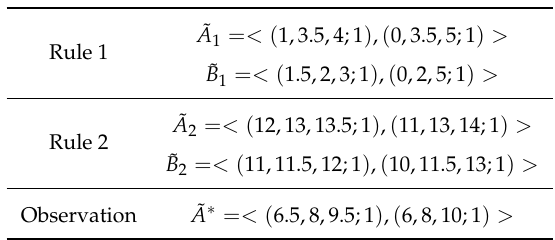
Table 1. Involved interval type-2 fuzzy sets for Case 1.